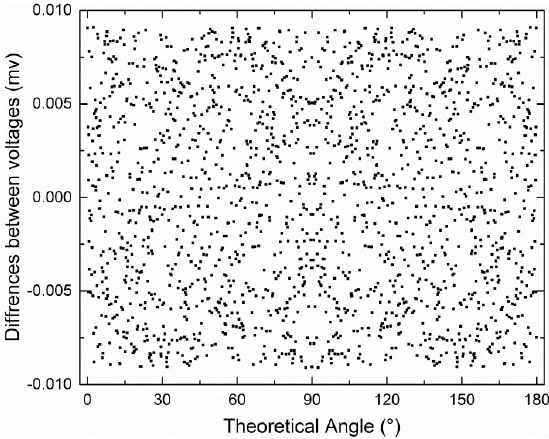
Figure 4. Difference between V 1_ ideal and V 1_ AD when d = 0.5.